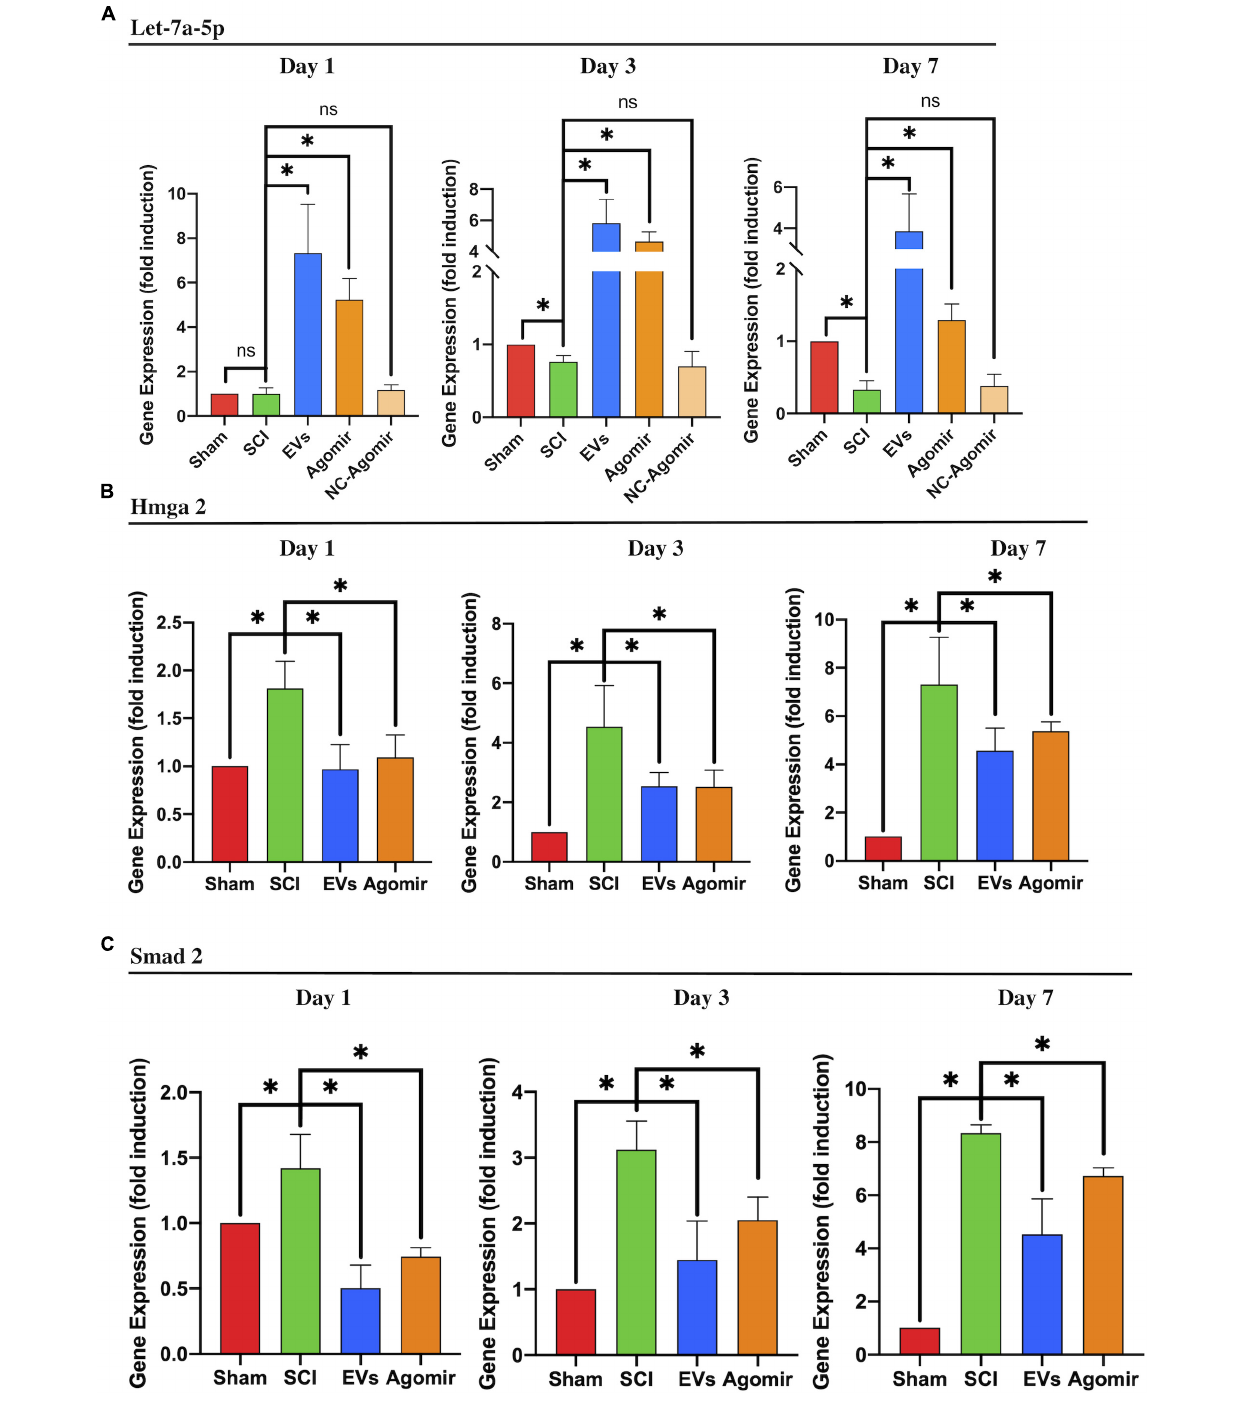
FIGURE 5 | BMSC-EVs and let-7a-5p agomirs inhibited the expression of SMAD2 by targeting HMGA2. (A) The injection of BMSC-EVs increased let-7a-5p expression in injured lesion at different time points following SCI. Similarly, the let-7a-5p agomirs increased let-7a-5p expression in the early time points following SCI ( n = 3). (B,C) In SCI rats, the expression of HMGA2 and SMAD2 in the injured lesion was markedly upregulated compared with the sham rats. Both BMSC-EVs or let-7a-5p agomirs were able to reduce HMGA2 and SMAD2 expression in SCI rats ( n = 3; data are mean ± S.D; Student’s t- test was used for comparisons; gene expressions were normalized to GAPDH (for mRNA) and U6 snRNA (for miRNA). ∗ p < 0.05. The term BMSC-EVs is abbreviated as EVs and let-7a-5p agomir is abbreviated as agomir.